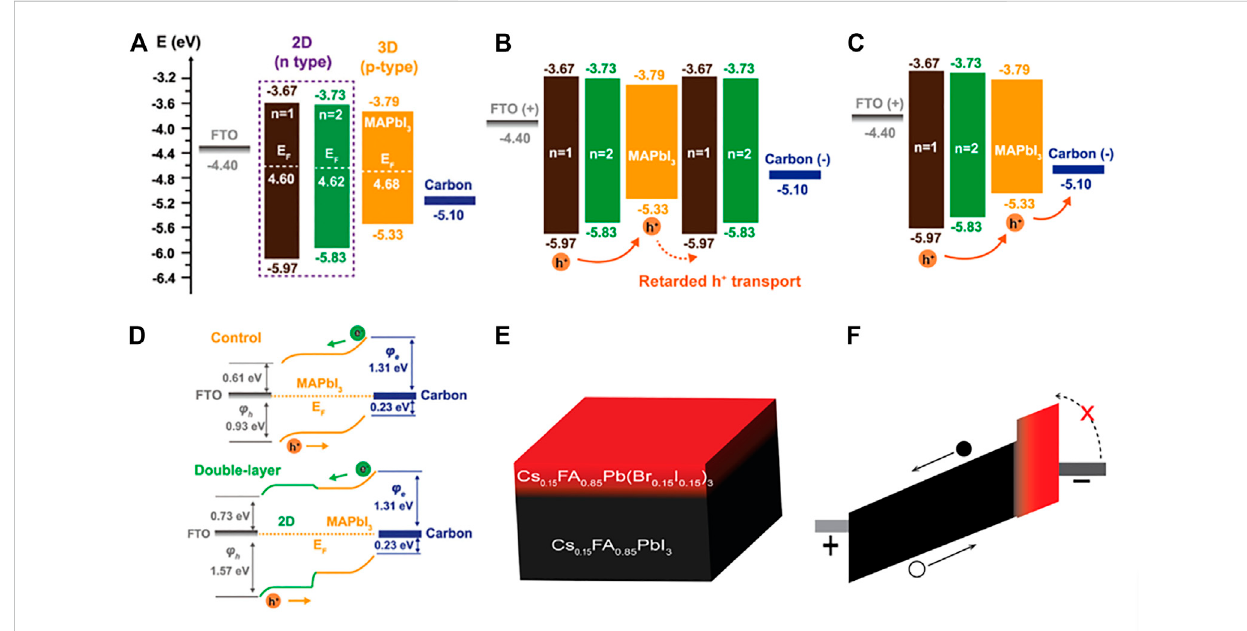
FIGURE 4 (A) Energy level diagram of 2D (PEA) 2 MA 3 Pb 4 I 13 3D MAPbI 3 heterosystem (n = 1,2 represent two phases of different annealing time). (B) Energy level diagram of 2D/3D/2D sandwich structure and (C) 2D/3D double layer structure. (D) Band alignment of 3D MAPbI 3 single component device and